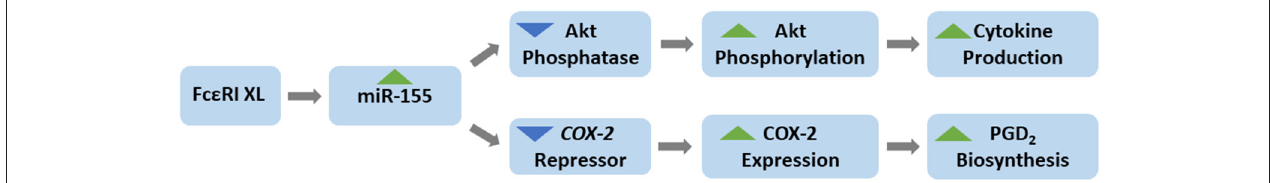
FIGURE 8 | Schematic of the role of miR-155 in mast cells. Fc ε RI crosslinking (XL) induces miR-155 expression in mast cells. miR-155 acts to inhibit the expression of an Akt phosphatase and a COX-2 repressor, thereby, facilitating Akt phosphorylation (activation) and COX-2 expression which normally occur following Fc ε RI XL. Increased Akt phosphorylation (activation) and COX-2 expression result in the production of cytokines and prostaglandins, respectively. Thus, miR-155 is a positive regulator of Fc ε RI-induced cytokine production and prostaglandin biosynthesis. miR-155 has no effect on degranulation or leukotriene production.